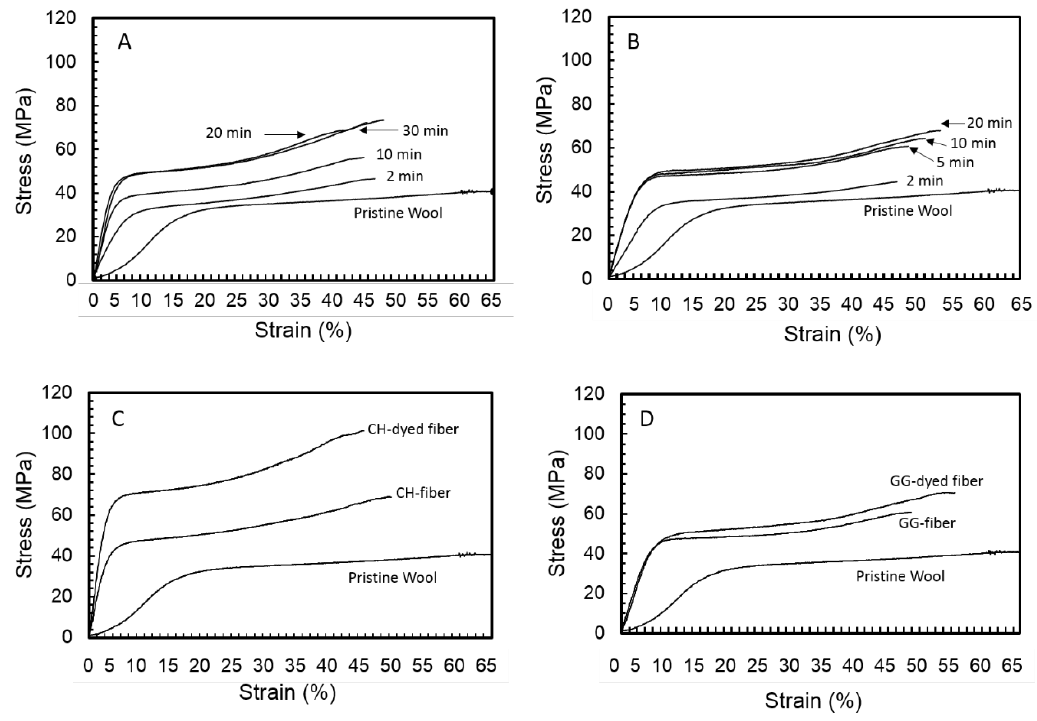
Figure 1. ( A , B ) Stress-strain curves of single-treated fiber at different duration of immersions; ( A ) chitosan (CH)-fiber, ( B ) gellan gum (GG)-fiber, ( C , D ) the comparison of stress-strain of dyed and un-dyed fibers; ( C ) CH at 20 min of immersion and ( D ) GG at 5 min of immersion.